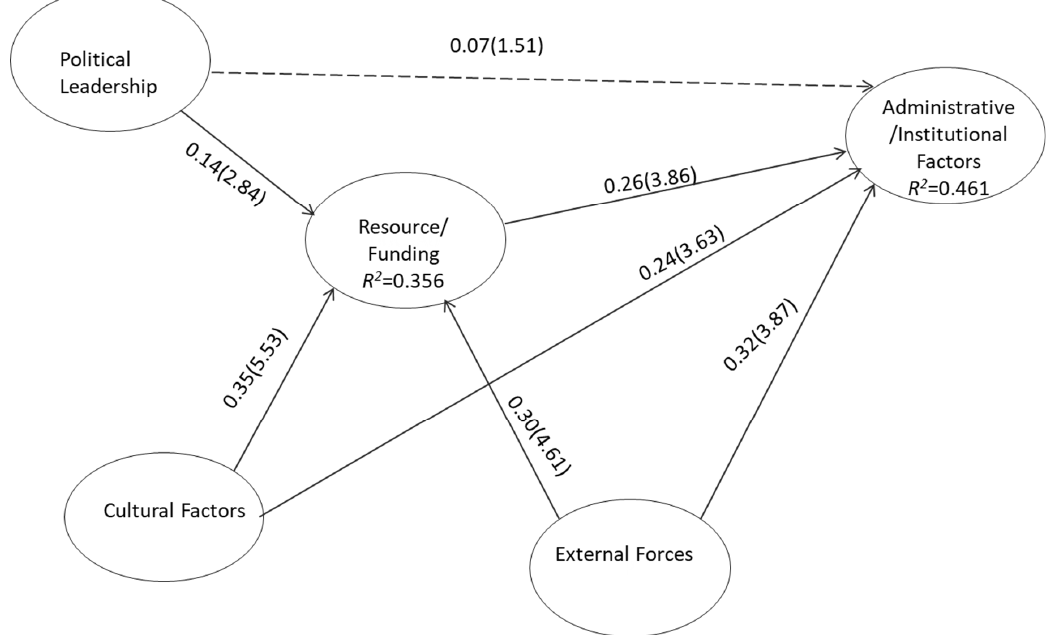
Fig. 1. Structural path coefficients showing regression weights, bootstrap t values (in parenthesis) and predictive accuracy in the endogenous variables. Note: Dotted line means the path is not statistically